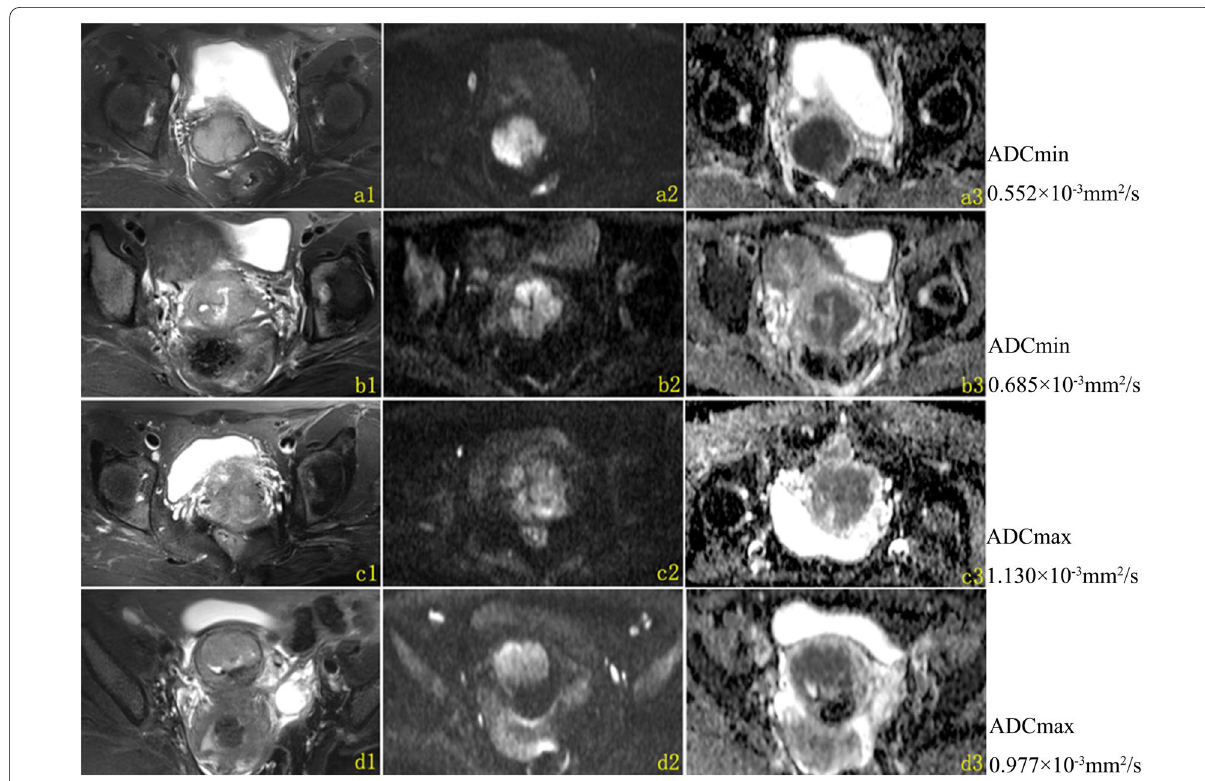
Fig. 6 Different ADCmax and ADCmin values of lesions treated with NAT RH ( a – b ) and CCRT ( c – d ); the maximum slice of the primary + tumor was showed on T2W(a1-d1), DWI(a2-d2) and ADC(a3-d3) map. a1 – 3 A 51-year-old patient treated with NAT RH, the ADCmin of + the primary tumor was 0.552 10 − 3 mm 2 /s, DFS was 11.23 months; b1 – 3 a 45-year-old patient treated with NAT RH, the ADCmin of the × + primary tumor was 0.685 10 − 3 mm 2 /s, DFS was 68.90 months; c1 – 3 a 48-year-old patient treated with CCRT, the ADCmax of the primary × tumor was 1.130 10 − 3 mm 2 /s, DFS was 10.70 months; d1 – 3 a 48-year-old patient treated with CCRT, the ADCmax of the primary tumor was × 0.977 10 − 3 mm 2 /s, DFS was 35.50 months . NAT RH, neoadjuvant therapy followed by radical hysterectomy; CCRT, concurrent chemoradiation; × + DFS, disease-free